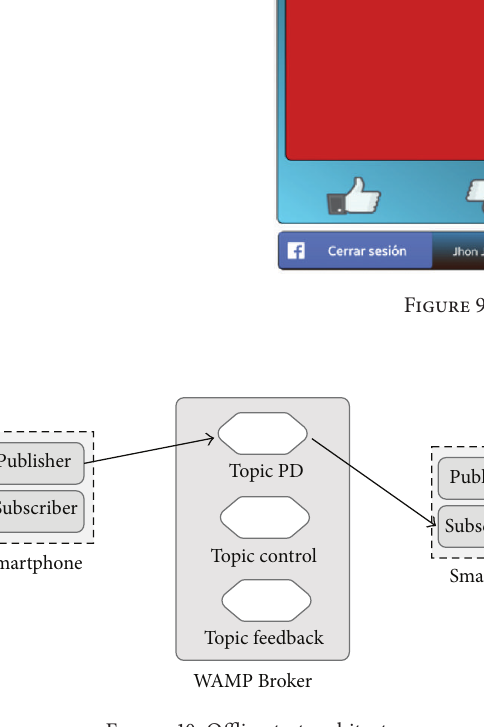
Figure 10: Offline test architecture.